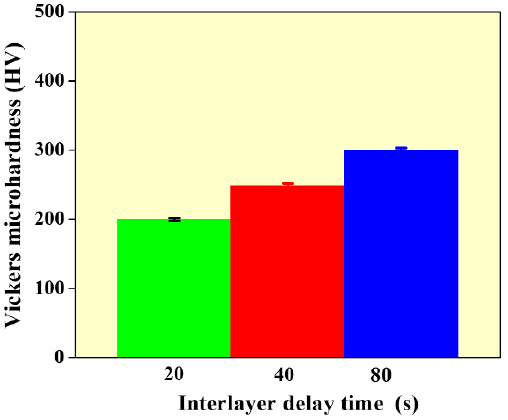
Figure 7. Vickers micro-hardness data as a function of interlayer delay.